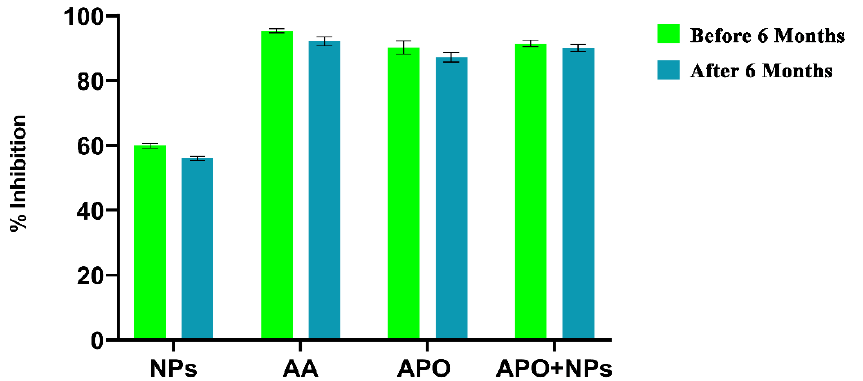
Figure 9. Comparative study by antioxidative analysis of the pure compound, NPs, and APO-loaded NPs using DPPH Assay.